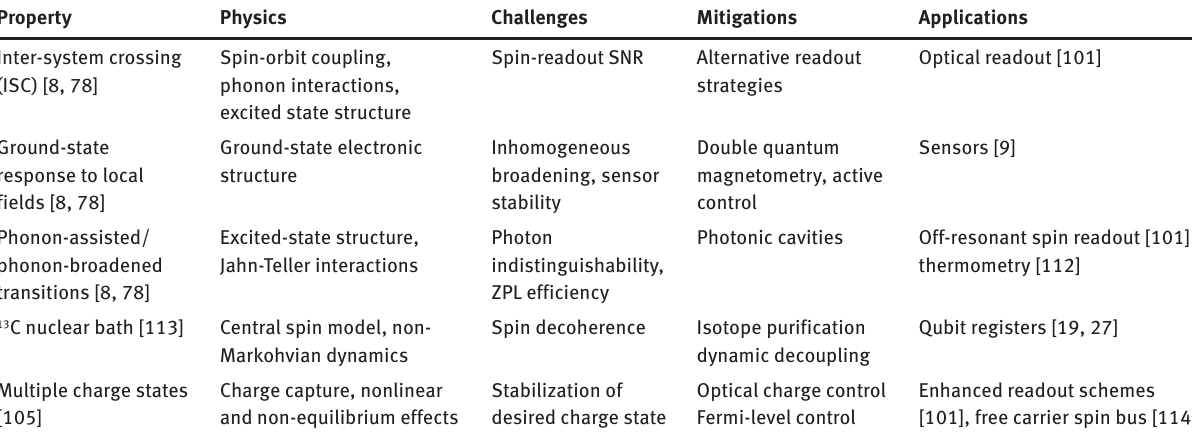
Table 1: Connections between the physical properties of a defect, in this case the NV center, and potential applications.